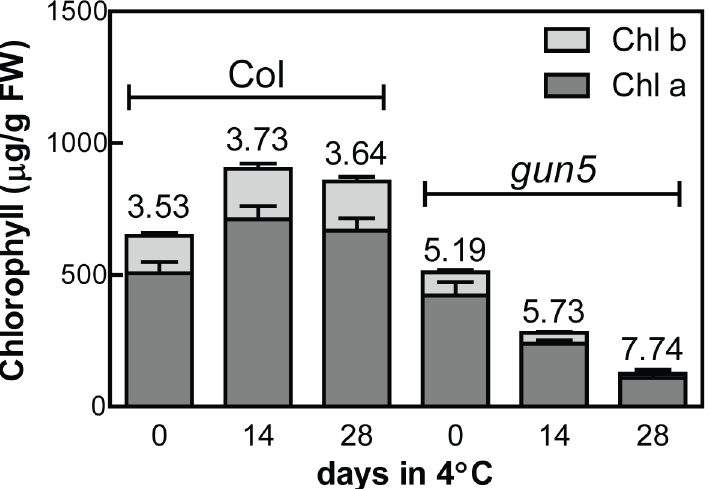
Fig 2. Chlorophyll content in Col-0 and gun5 plants following exposure to low temperatures. Samples were taken from 5 week old plants grown under short day conditions (time point 0) and after indicated days grown in 4°C, short days conditions. Above each column is the Chl a/b ratio from each sample. Values represent at least 6 biological replicates ( ± SD).